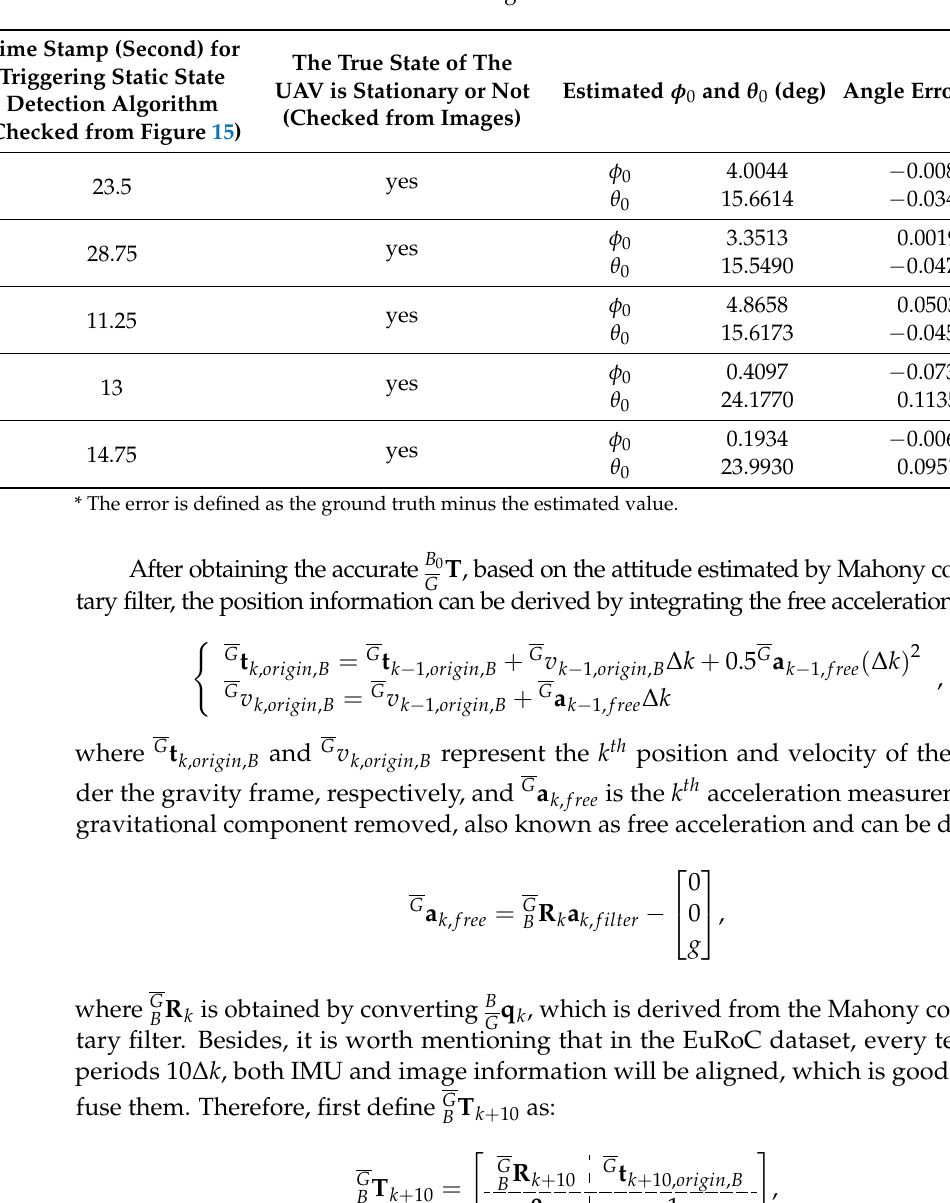
T calculation. Figure 16. Flowchart of B 0 Figure 16. Flowchart of G Table 5. Results of a static state detection algorithm for the EuRoC